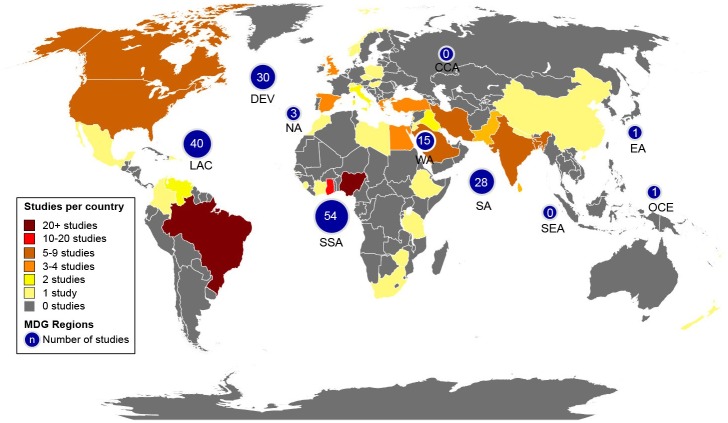
Geographic map of included studies.Distribution of included studies across Millennium Development Goal regions and country.